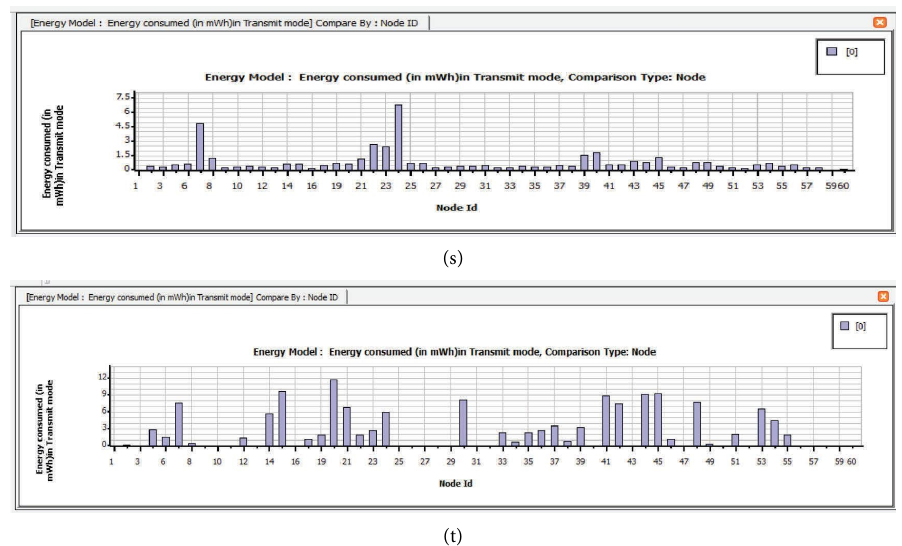
Figure 10: (a) Transmit mode power consumption (mWh) of AODV for 60 nodes. (b) Transmit mode power consumption (mWh) of DSR for 60 nodes. (c) Transmit mode power consumption (mWh) of DYMO for 60 nodes. (d) Transmit mode power consumption (mWh) of LAR1 for 60 nodes. (e) Transmit mode power consumption (mWh) of OLSR for 60 nodes. (f) Transmit mode power consumption (mWh) of Bellman–Ford for 60 nodes. (g) Transmit mode power consumption (mWh) of Fisheye for 60 nodes. (h) Transmit mode power consumption (mWh) of STAR-LORA for 60 nodes. (i) Transmit mode power consumption (mWh) of ZRP for 60 nodes. (j) Transmit mode power consumption (mWh) of STAR-ORA for 60 nodes. (k) Transmit mode power consumption (mWh) of AODV for 120 nodes. (l) Transmit mode power consumption (mWh) of DSR for 120 nodes. (m) Transmit mode power consumption (mWh) of DYMO for 120 nodes. (n) Transmit mode power consumption (mWh) of LAR1 for 120 nodes. (o) transmit mode power consumption (mWh) of OLSR for 120 nodes. (p) Transmit mode power consumption (mWh) of Bellman–Ford for 120 nodes. (q) Transmit mode power consumption (mWh) of fsheye for 120 nodes. (r) Transmit mode power consumption (mWh) of STAR-ORA for 120 nodes. (s) Transmit mode power consumption